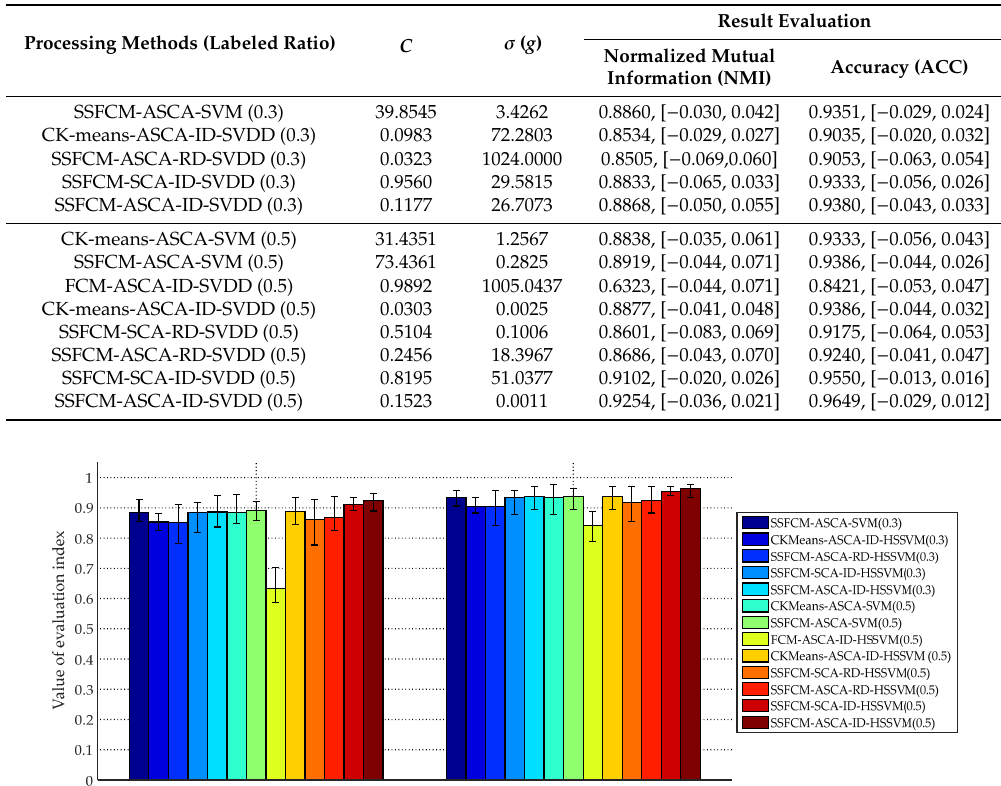
Figure 10. Comparison of evaluation values for different methods.